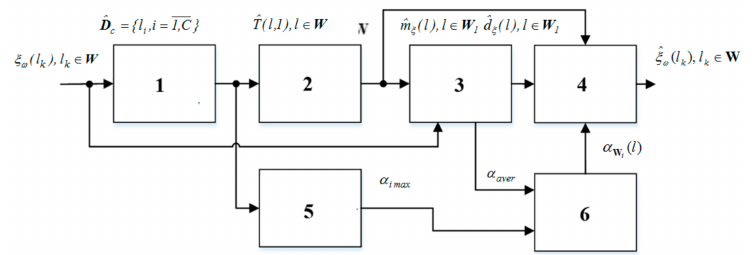
Figure 3. Block diagram of the computer modeling of the microrelief process (new approach): 1—assessment of the segmental structure of the microrelief; 2—assessment of the rhythmic structure of microrelief; 3—statistical processing of microrelief; 4—cyclic microrelief modeling; 5—determination of maximums of segments-cycles of microrelief; 6—estimation of the scale factors